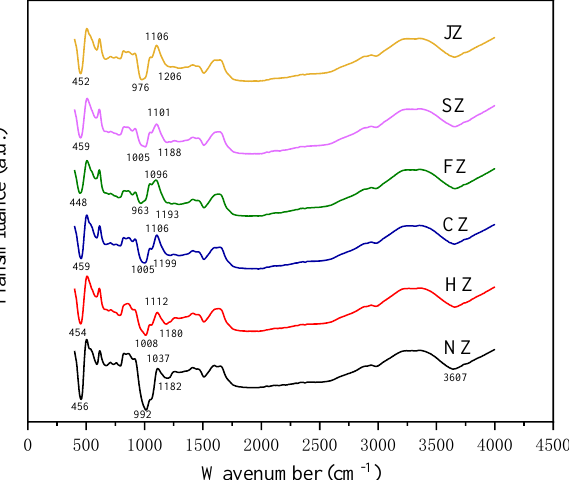
Figure 2. Fourier transform infrared spectroscopy results of zeolite. SZ: Na 2 S modification; JZ: NaOH modification; CZ: ultrasonic modification; FZ: humic acid modification; HZ: high-temperature modification; NZ: natural